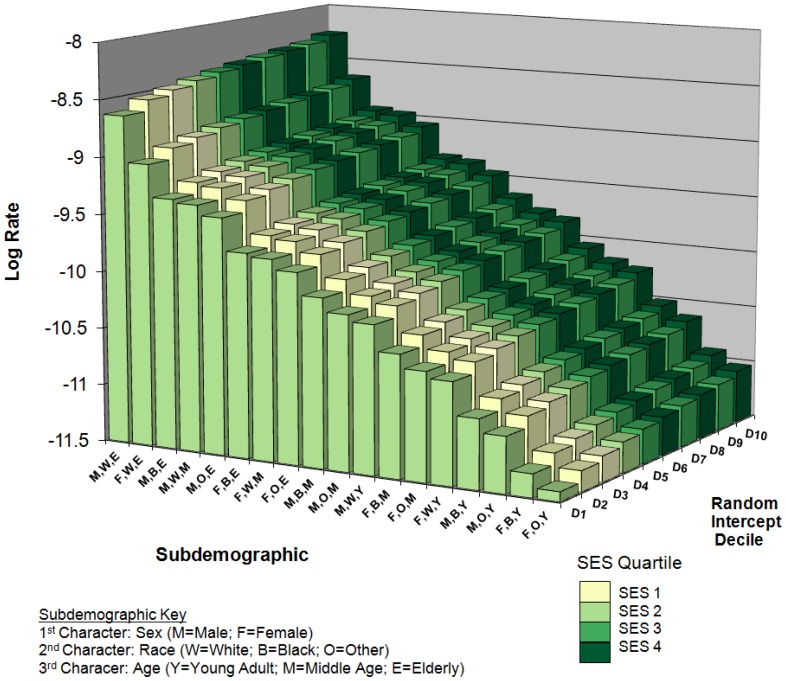
Bar Chart Summary of Estimated Log Rates by Subdemographic and County Random Intercept Decilea,b.
 aUnstandardized rates produced from model 2, year 2000 estimates. bDeciles (D1–D10) represent the median random intercept values within each decile of random intercepts.